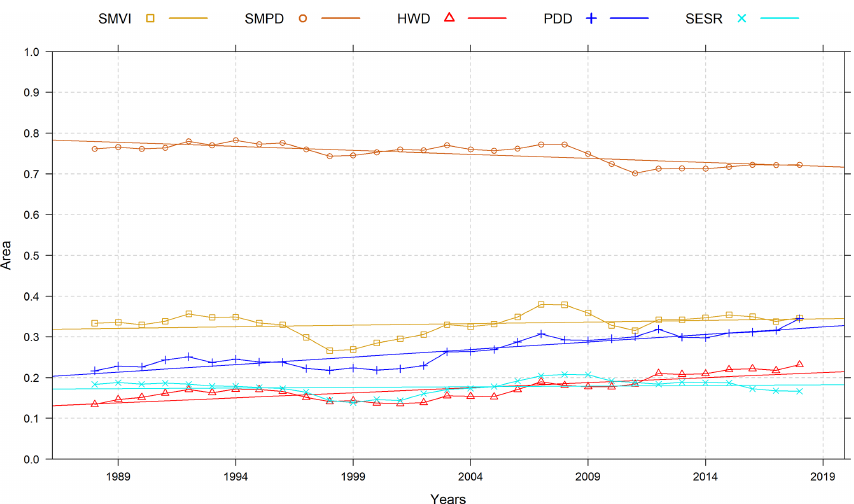
Figure 9. 10-year running average percentage of area hit by flash droughts in CONUS from March to November, as estimated by different definitions from 1979 to 2018. Linear trends are represented by the straight solid